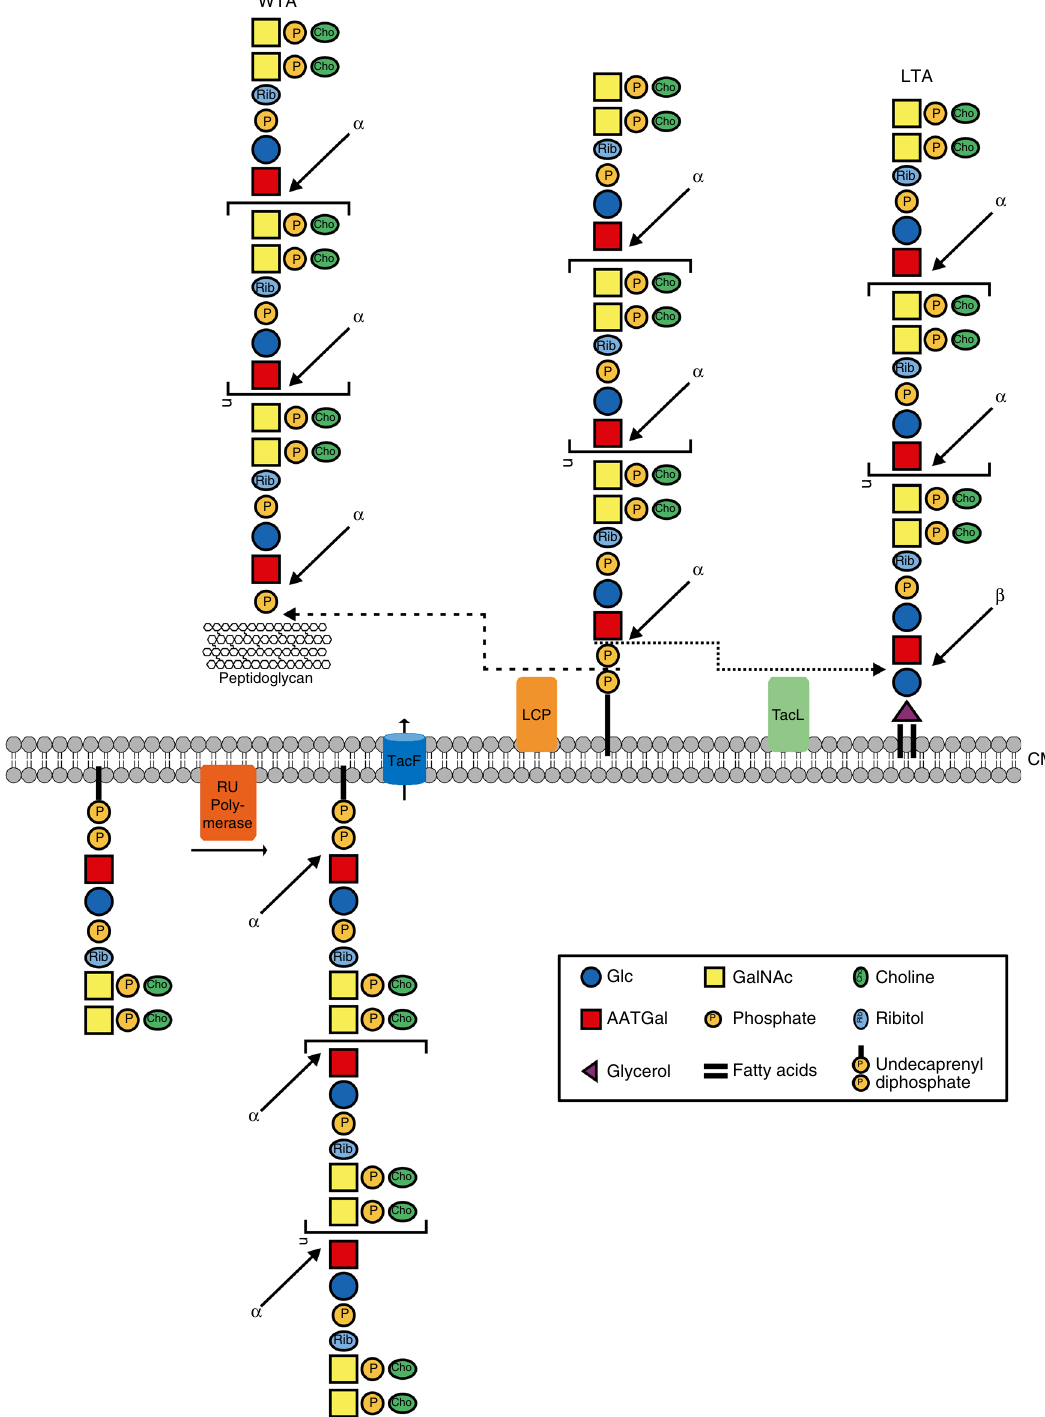
Fig. 6 Last steps in the TA biosynthesis pathway in S. pneumoniae . The Und- PP -linked monomeric repeats are polymerized by the RU polymerase and transported through the cytosolic membrane by TacF. The complete biosynthesis pathway is reviewed and discussed in ref. 15 . Finally, the pnTA precursor chain is transferred onto the PGN to form the pnWTA or onto the glycolipid anchor to form the pnLTA, respectively. The transfer to the PGN is performed — most likely in a semi-redundant manner 19 — by the LCP proteins Psr, LytR, and Cps2A. Here the TA chain is transferred including one phosphate, thus retaining the anomeric α -con fi guration of the AATGal p moiety of the fi rst RU. In pnLTA formation, a new glycosidic bond between the glucose moiety of the glycolipid anchor and the fi rst AATGal p is formed. We propose that TacL may catalyze this reaction, which inverts the stereochemistry of the anomeric carbon leading to the β -con fi guration of the AATGal p moiety of the fi rst RU in pnLTA. From these observations, it can be concluded that the Und- PP -linked pnTA precursor chains are synthesized with all AATGal p moieties in the α -con fi guration. AATGal 2-acetamido-4-amino-2,4,6-trideoxygalactose, CM cytoplasmic membrane, GalNAc N -acetylgalactosamine, Glc glucose, LCP LytR-Cps2A-Psr family